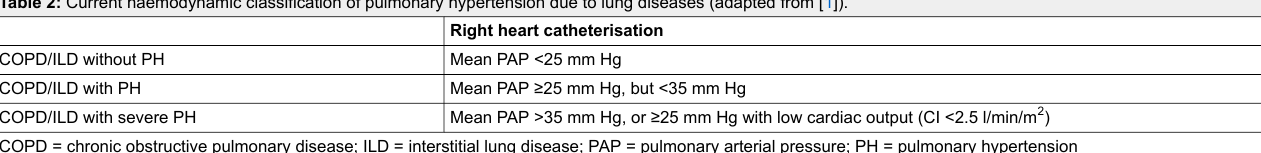
Right heart catheterisation